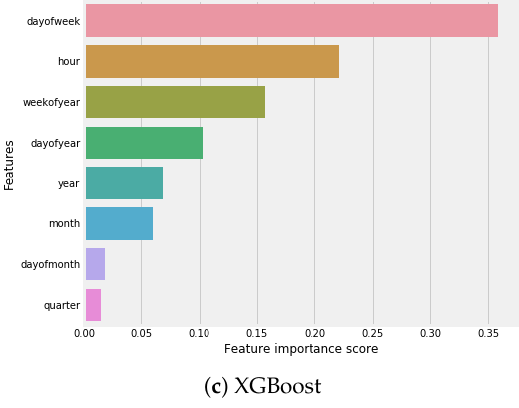
Figure 14. Feature importance with ML models.